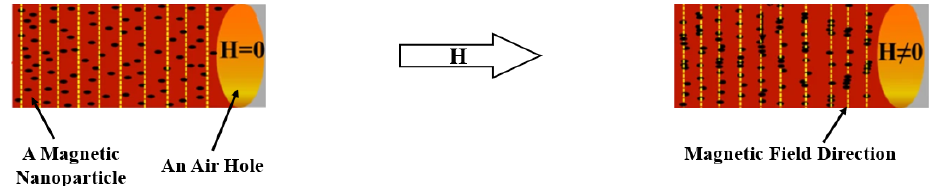
Figure 1. Nanoparticles of MF are rearranged under an external magnetic field (reprinted and adapted with permission from Ref. [24], 2022, Springer